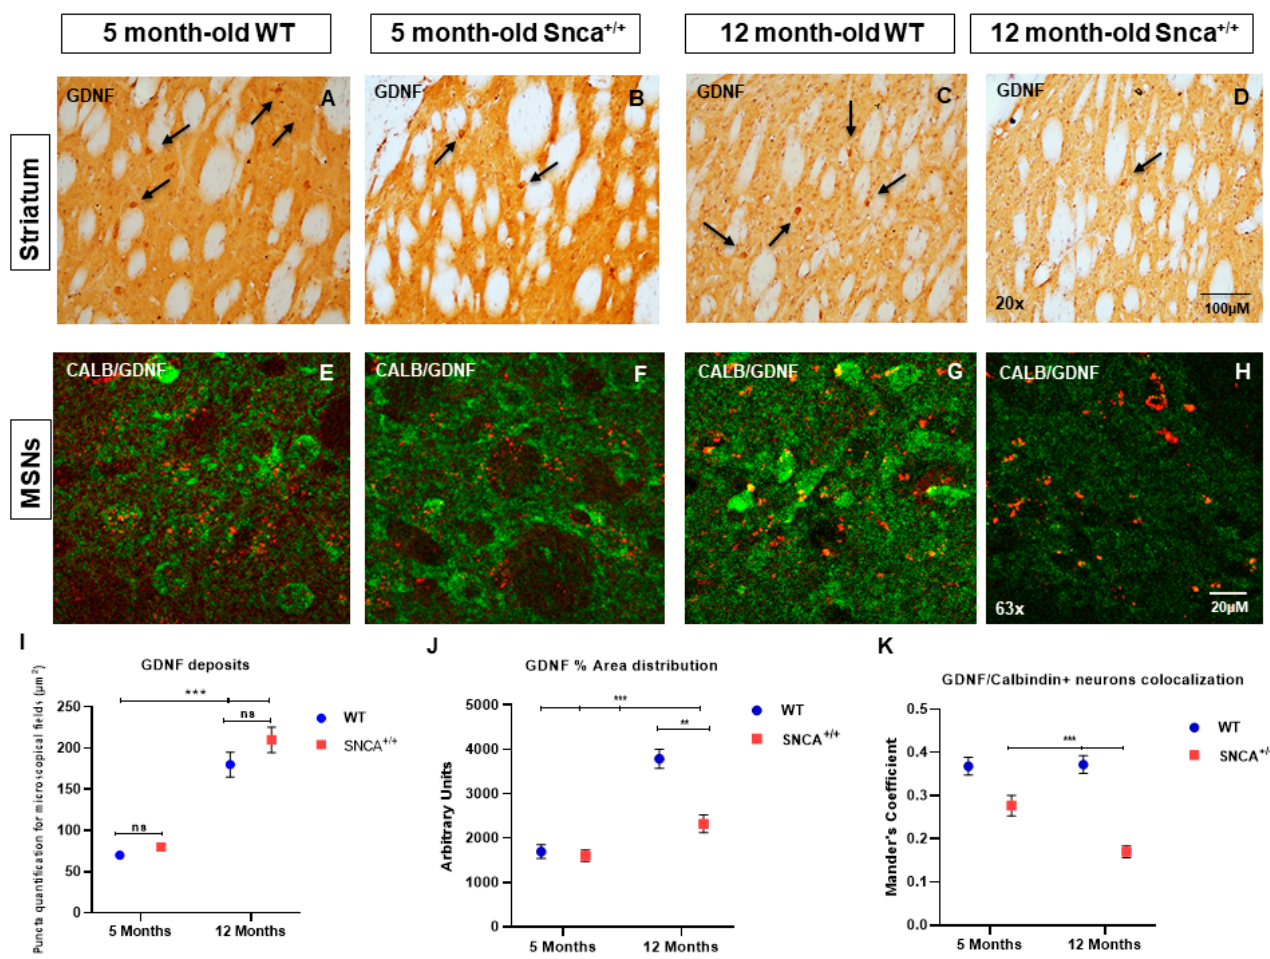
Figure 4. ( A – H ) GDNF in striatal projection neurons of WT and Snca +/+ rats. Representative transmitted light microscope images showing Dab staining for GDNF counterstained with Hematoxylin in the striatum of 5- and 12-month-old Wt and Snca +/+ rats. ( Arrows show the distribution of GDNF in the interneurons ). Two-way ANOVA revealed a statistically significant effect of Time (F1.157 = 115.1; *** p < 0.001) in GDNF deposit formation in the experimental groups of 5- and 12-month-old WT and Snca +/+ rats, and a statistically significant genotype and time effect in GDNF area distribution [genotype F(1.157) = 17.84 ** p < 0.01; time F(1.157) = 57.99; *** p < 0.001]. “ns” means “not significant”. ( I ) GDNF deposits; ( J ) GDNF% area distribution; ( K ) GDNF/Calbindin + neurons